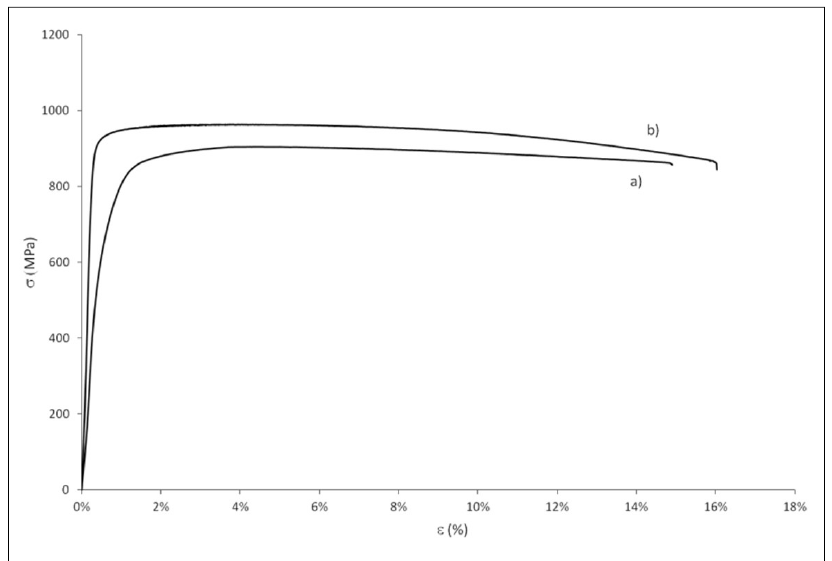
Figure 20. Stress–strain curves at room temperature for specimens B: ( a ) HIPped specimen; ( b ) HIPped and machined specimen.